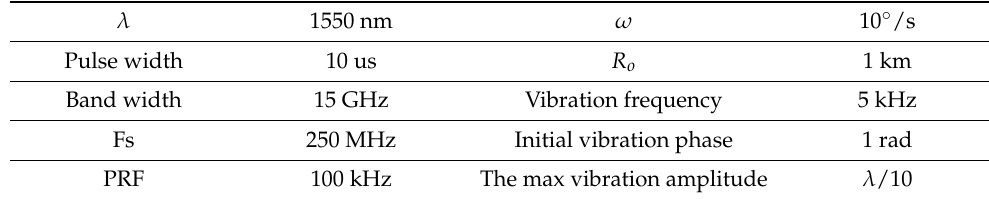
Table 1. Parameters used in the simulation.